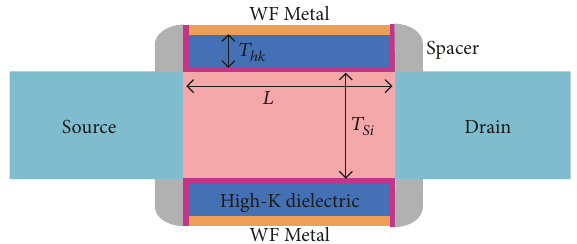
Figure 2: The cross section of the symmetric Independent-Gate High-K Metal gate FinFET with interfacial oxide between chan- nel and high-k dielectric in TCAD simulation ( N =1.0e12cm −3 , L =14nm, HFin N body